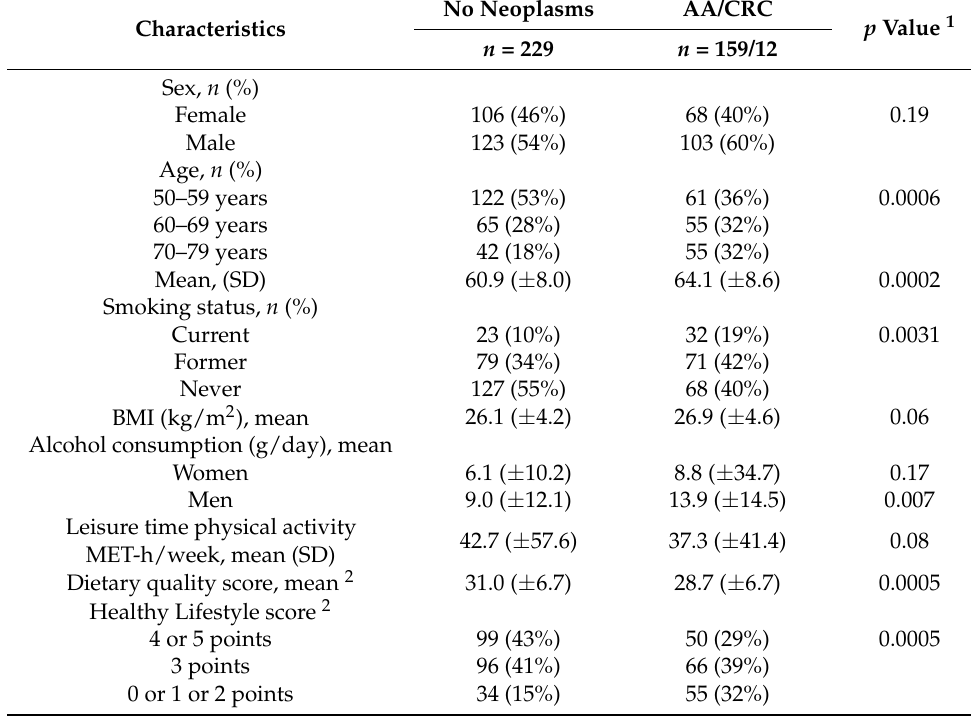
Table 1. Characteristics of the study participants.